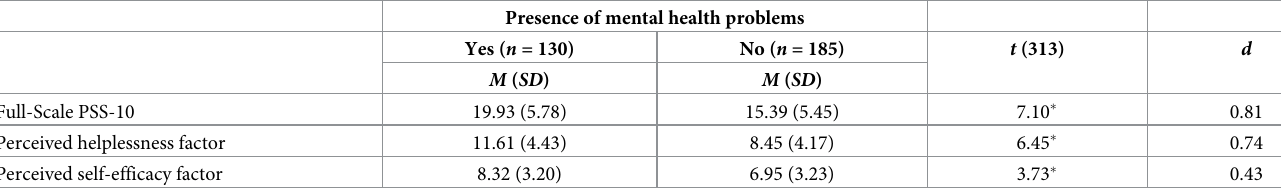
Table 2. Mean difference of the PSS-10 scores between individuals with and without mental health problems, as indicated by the